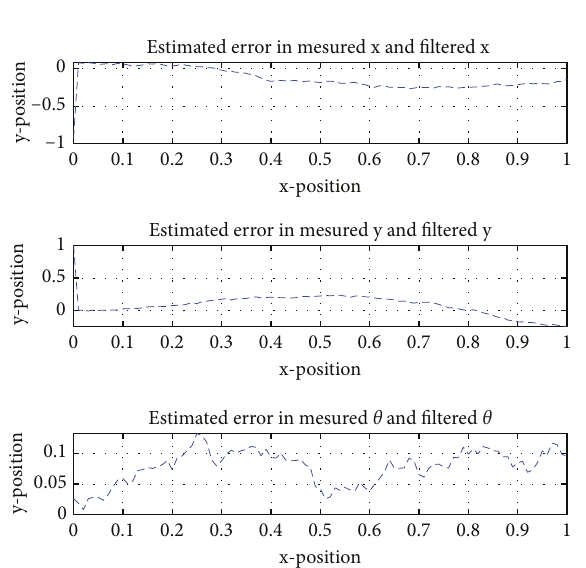
Figure 13: Localization error with the PF (one landmark and Gaussian noise). Table 9: The mean of the experiments with the PF (one